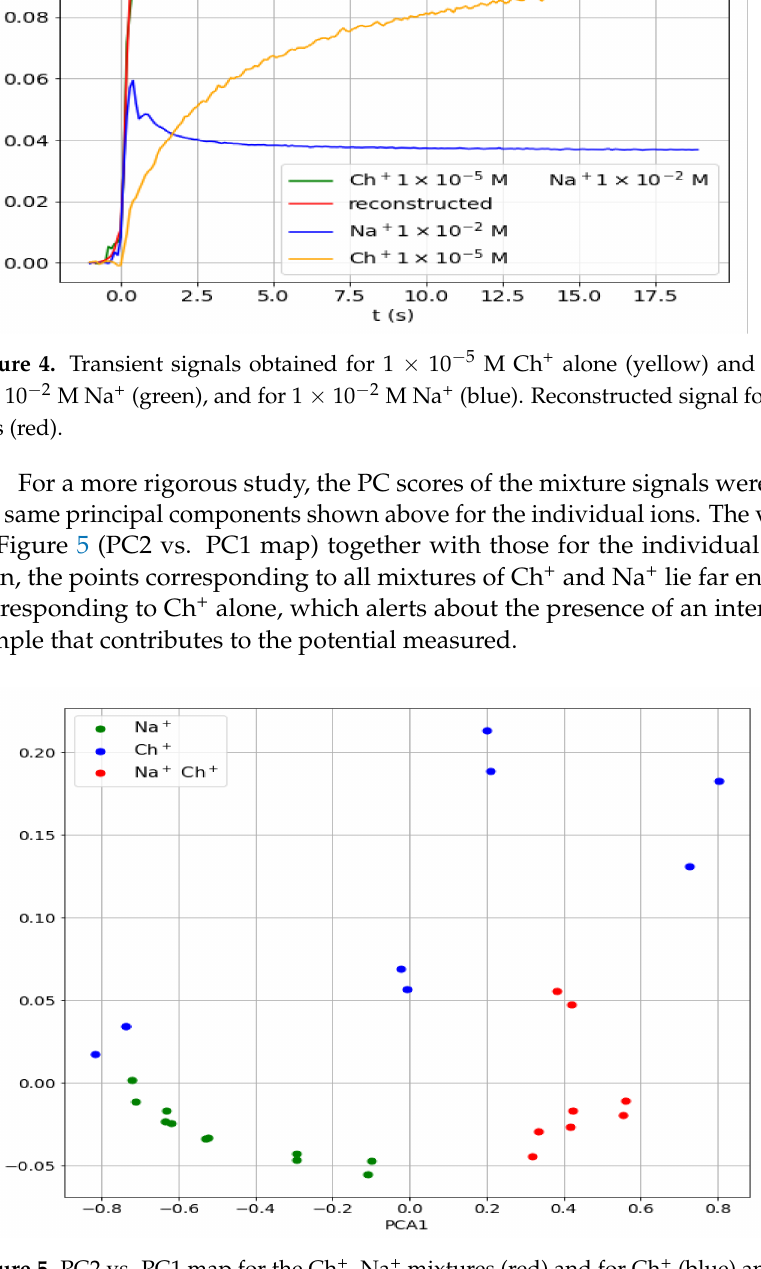
Figure 5. PC2 vs. PC1 map for the Ch + , Na + mixtures (red) and for Ch + (blue) and Na +